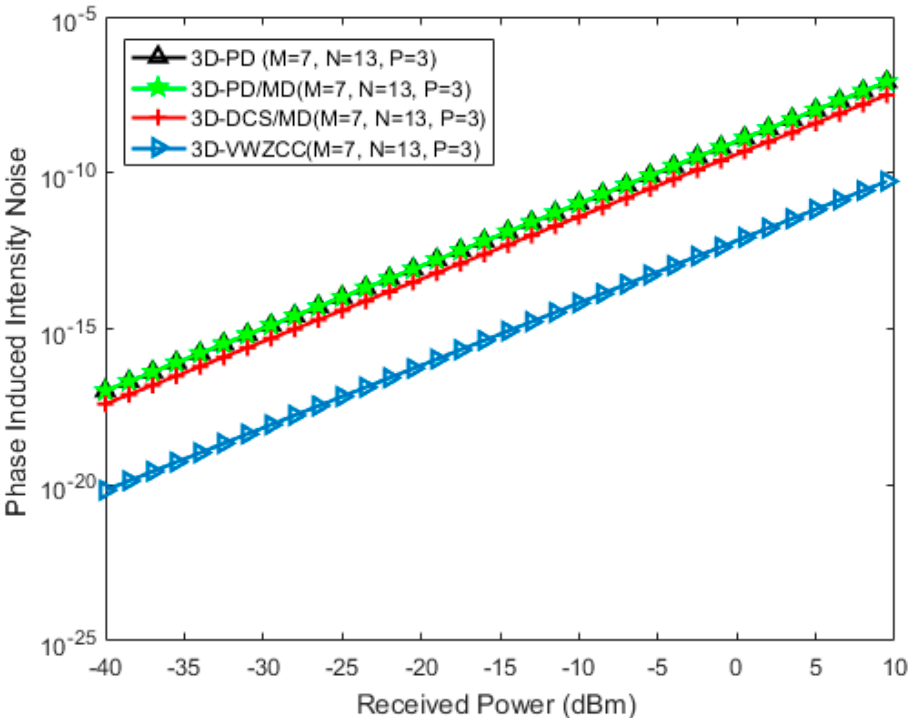
Figure 10. Phase-induced intensity noise against received power when the number of simultaneous users K = 250 and data rate R b = 1.25 Gbps.